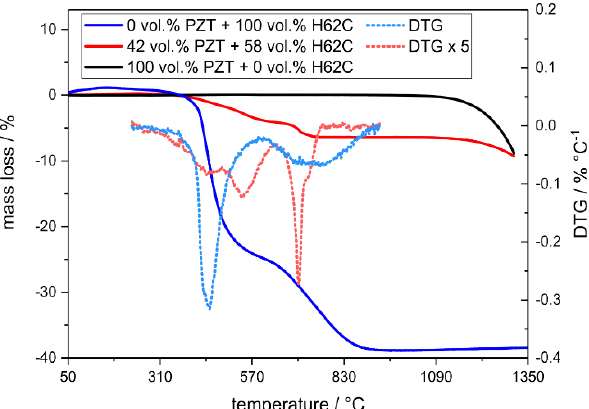
Figure 2. Thermogravimetry of the pure, hydrophobized PZT powder (black line), a composite material containing 42 vol.% PZT (red line) and of the pure H62C silsesqioxane polymer (blue line). The dotted lines show the first derivative of the respective thermogravimetry data (DTG).